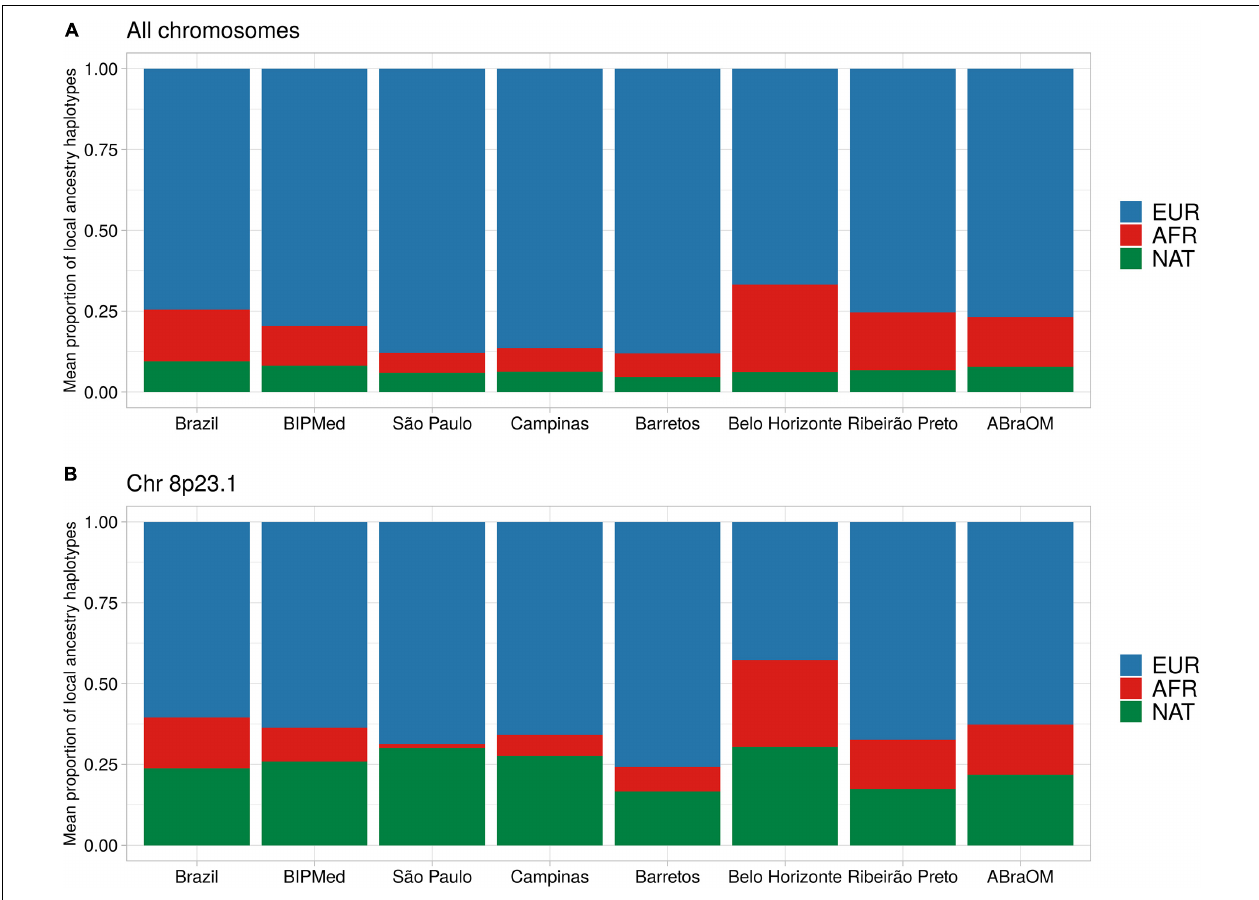
FIGURE 2 | Barplot of the mean proportion of local ancestry haplotypes. Each bar represents one Brazilian sample. (A) Mean local ancestry haplotypes across all exomes. (B) Mean local ancestry haplotypes on chr8p23.1. EUR, European ancestry component; AFR, African ancestry component; NAT, Native-American ancestry